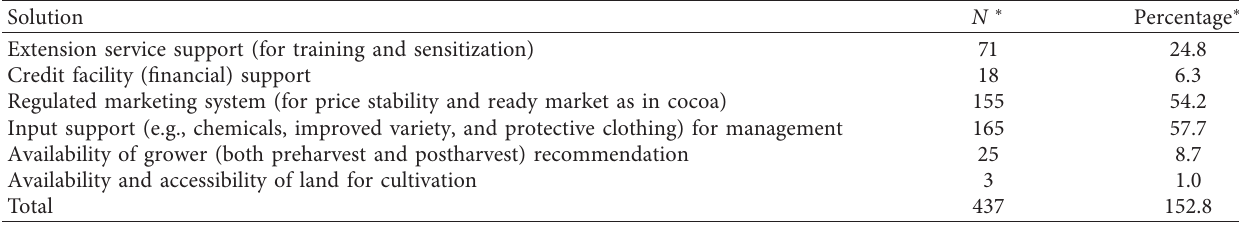
Table 8: Suggested solutions to constraints faced in kola